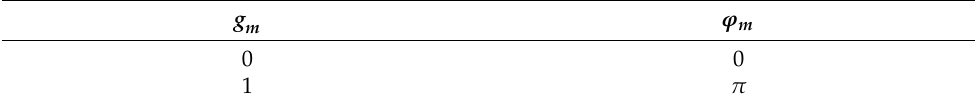
Table 1. Mapping of information bits onto ϕ m for DBPSK.